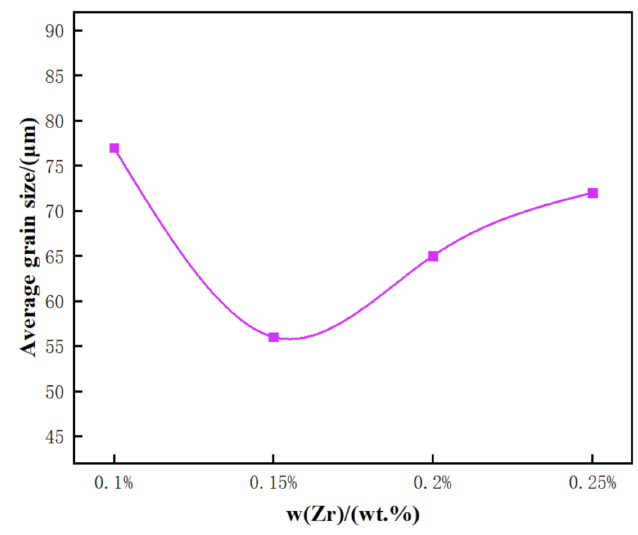
Figure 3. The variation of average grain size with Zr content.